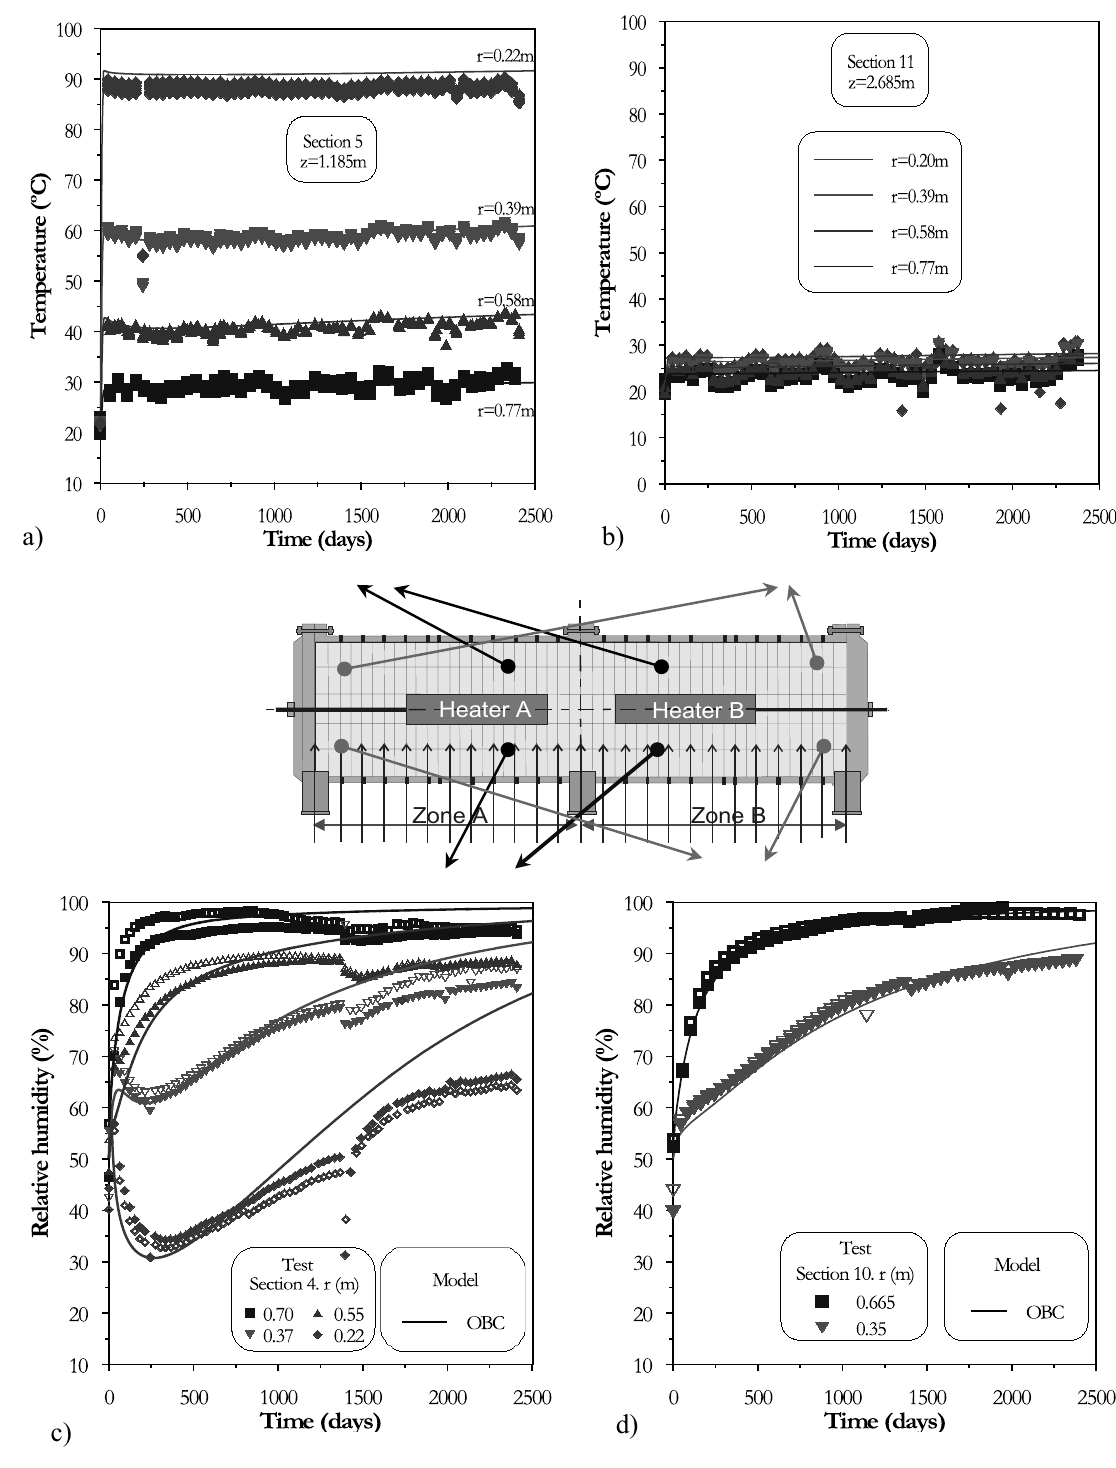
Fig. 9 – Mock-up test: observed versus computed values, (OBC model). Evolution of the temperature in a typical ‘hot cross section’ a); and in a typical ‘cold cross section’ b). Evolution of the relative humidity in a typical ‘hot cross section’ c); and in a typical ‘cold cross section’